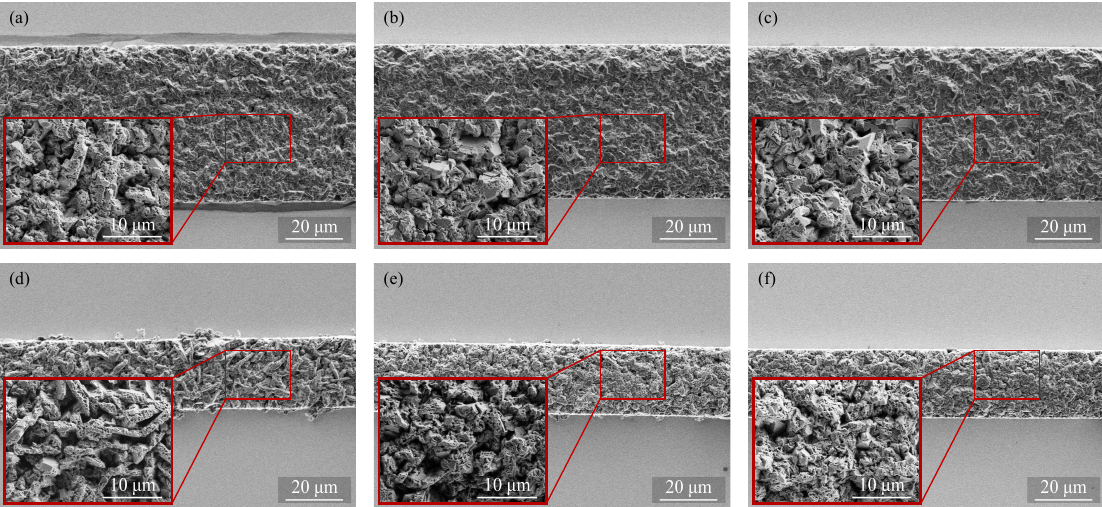
Figure 12. SEM images of the pattern-deposited films with 50 µm frame width obtained at ( a ) 10; ( b ) 15; ( c ) 20 mA/cm 2 and with 20 µm frame width obtained at ( d ) 10; ( e ) 15; and ( f ) 20 mA/cm 2 .